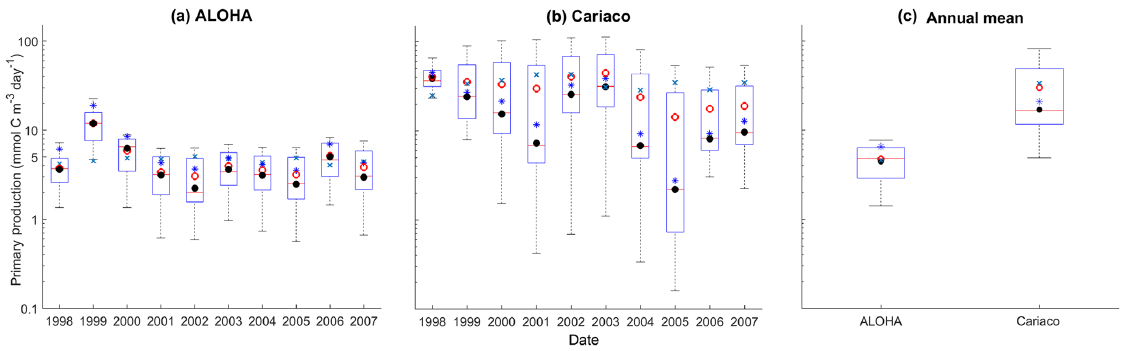
Figure 10. Mean integrated primary production averaged over 200m that is available in (a) ALOHA and (b) Cariaco, and (c) the annual mean. The NRRs for ALOHA and Cariaco are 1.12 and 0.80